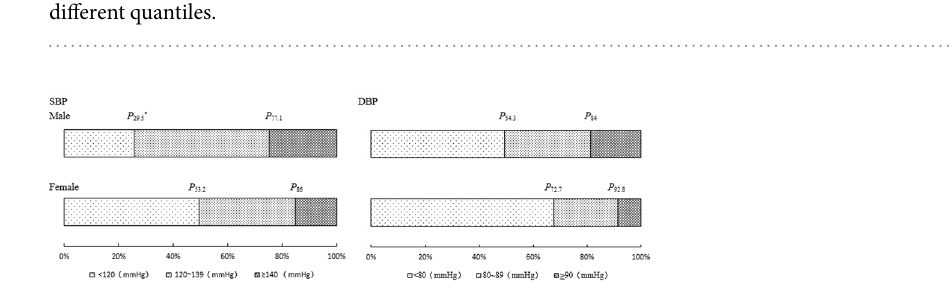
Figure 1. Distribution of BP in males and females. * P x : percentile x; SBP: systolic blood pressure; and DBP: diastolic blood pressure.